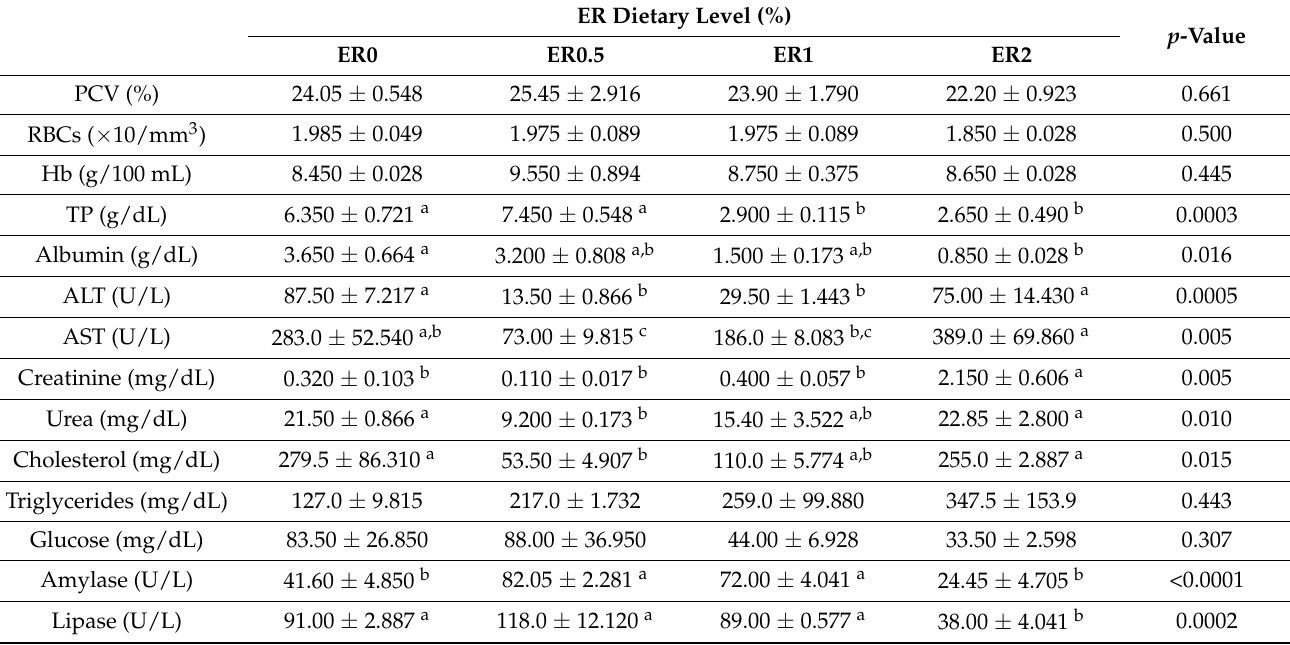
Table 6. Haemato-biochemical profile of Red tilapia fed different dietary levels of